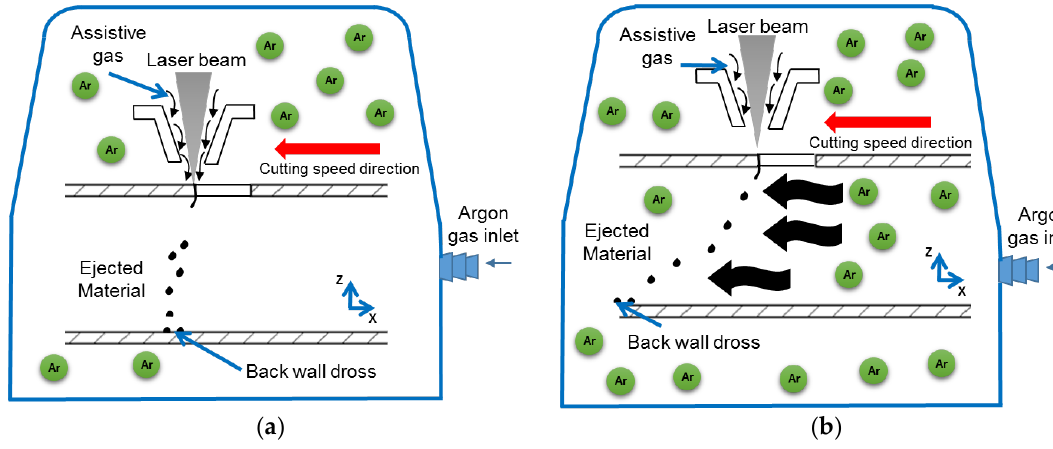
Figure 2 . Experimental conditions under study: ( a ) Ar assistive atmosphere; ( b ) Ar assistive atmosphere and blowing through the tube.